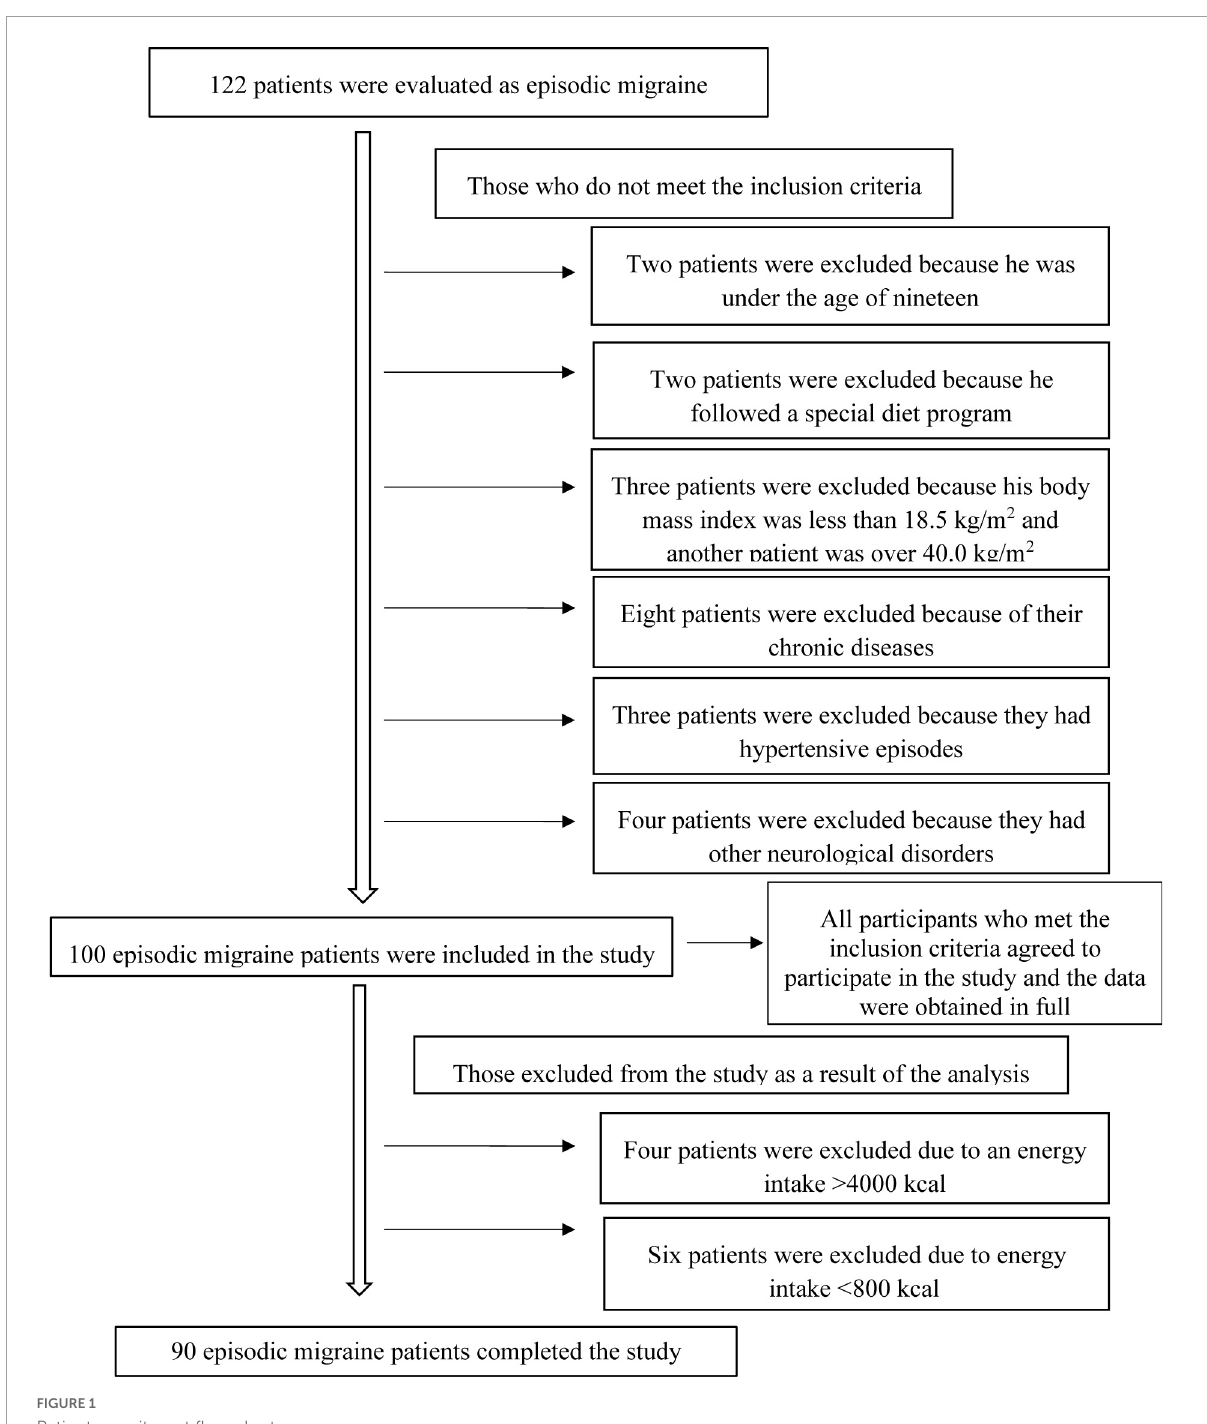
FIGURE1 Patient recruitment flow